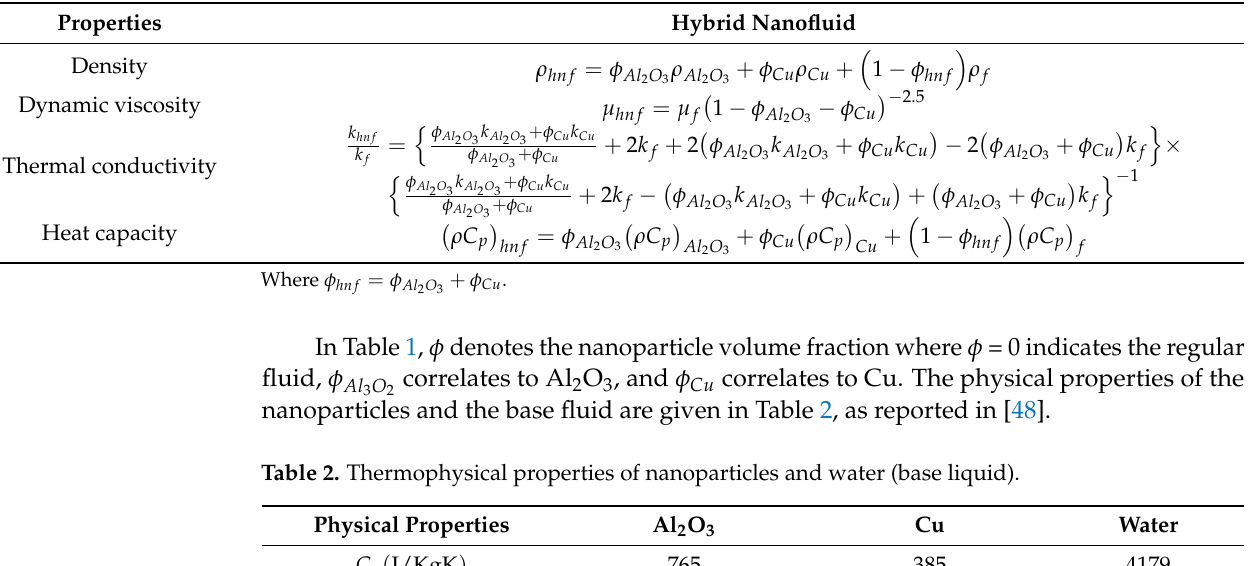
Table 1. Thermophysical properties.